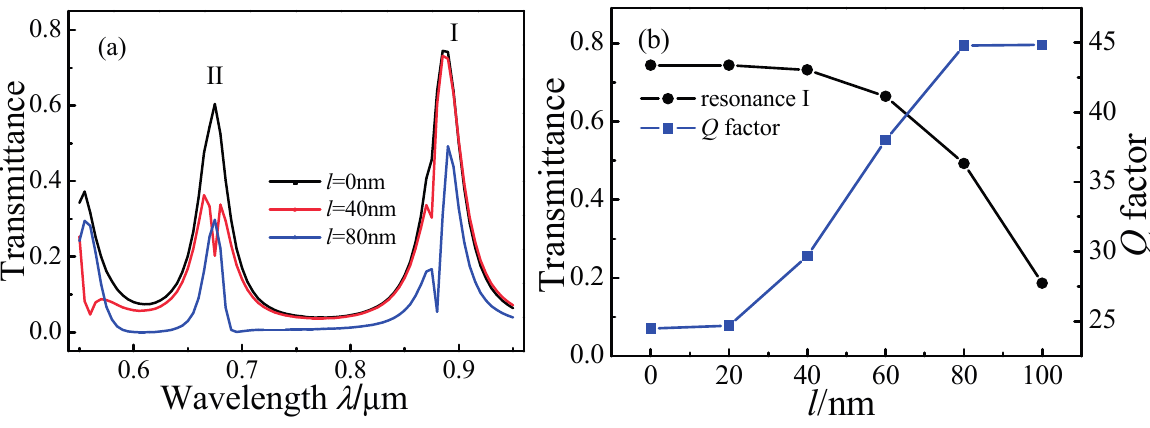
Figure 7. Transmission spectra of MIM waveguide-coupled ring resonators as a function of l . ( a ) Spectra for l = 0 nm, 40 nm, and 80 nm; ( b ) Transmittance of peak I and Q factor as a function of